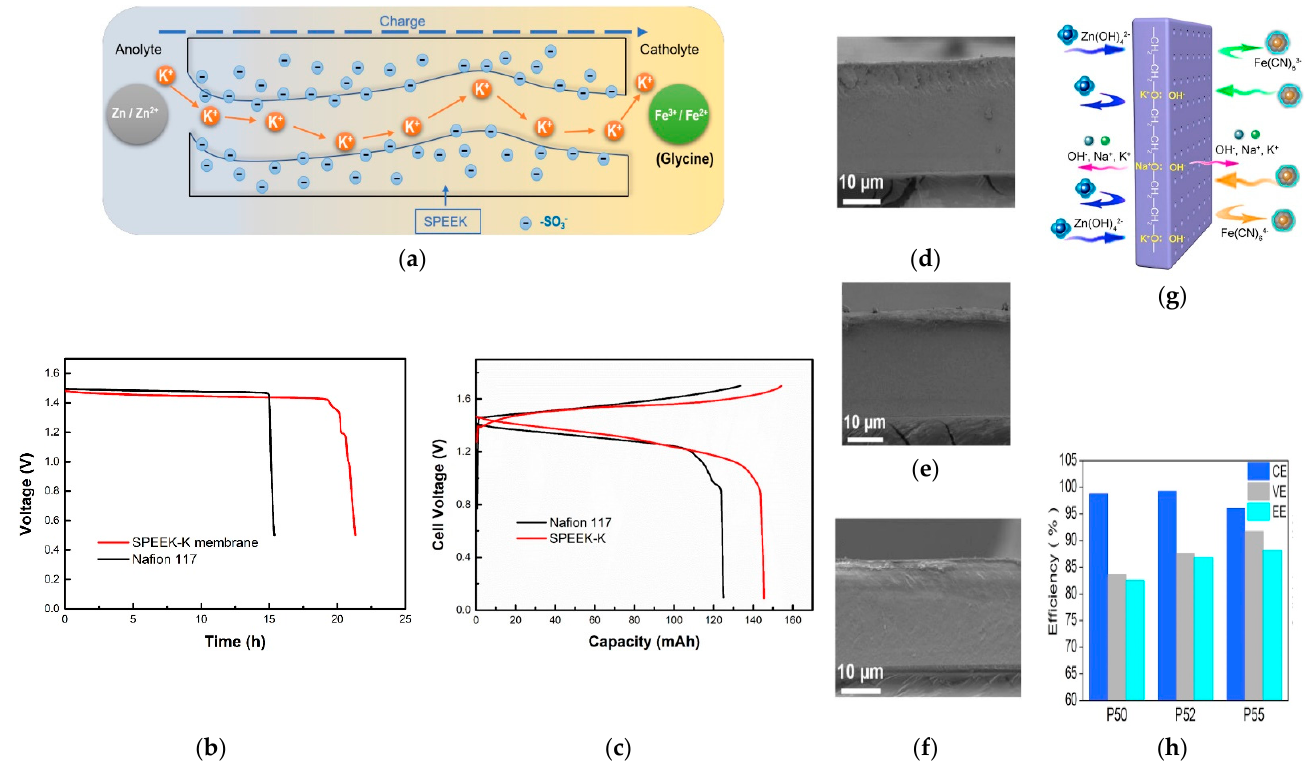
Figure 8. ( a ) Schematic illustration of ZIRFBs employing the SPEEK-K membrane; ( b ) the OCP curves of the single-cell with SPEEK-K and N117 membrane; ( c ) the second cycle charge–discharge curves of SPEEK-K and N117 membrane at 40 mA cm − 2 ; reproduced with permission from [95]. Copyright 2019, Elsevier. Cross-section morphologies of P50 ( d ), P52 ( e ), and P55 ( f ); ( g ) schematic illustration of a non-ionic membrane in a ZIRFB; ( h ) the efficiencies of ZIRFBs assembled with various membranes in ( d – f ) under 80 mA cm − 2 . Reproduced with permission from [96]. Copyright 2021, Elsevier.